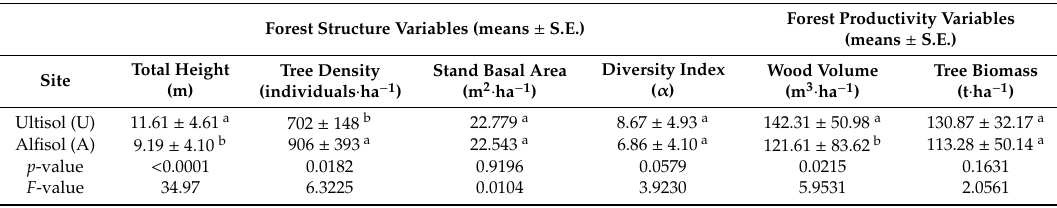
Table 2. Di ff erences between experimental sites in stand structure and wood productivity after 19–20 years of implementation. The di ff erent restoration systems were pooled. Forest Structure Variables (means ±